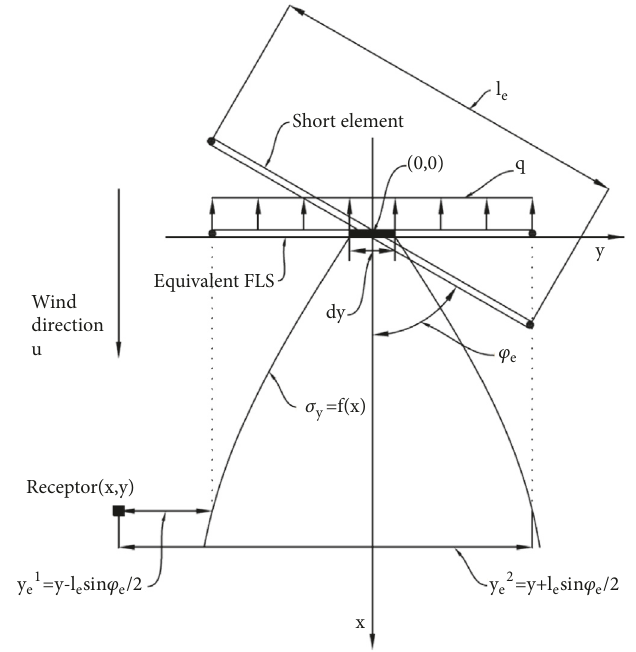
Figure 1: Dispersion from a short element/equivalent